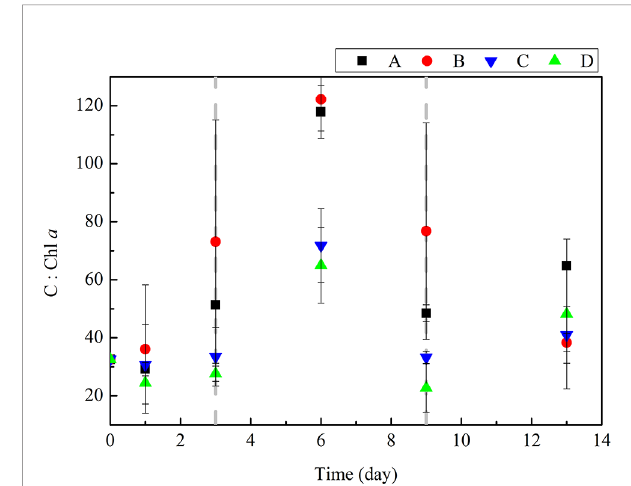
FIGURE 4 | The relationship between NH + 4 /DIN and D DOC in different algae phases of the four groups. FIGURE 5 | Changes in C: Chl a during the incubation